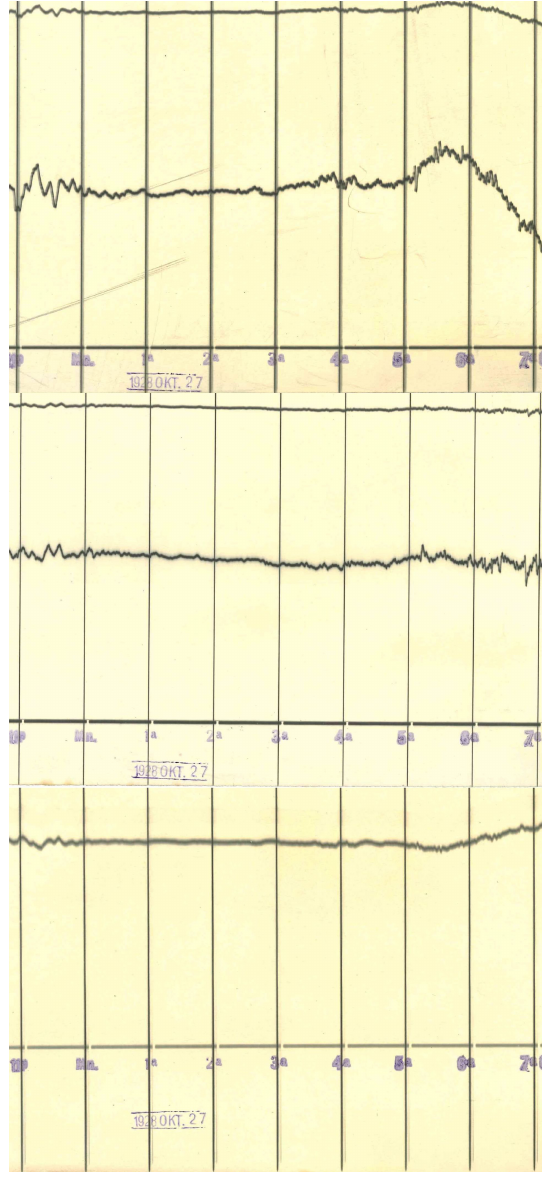
Figure 11. Seddin Observatory photographic recordings of the north (top), east (middle) and vertical component (bottom) of the time interval of 26 October 1928 at 23:00 till 27 October 1928 at 07:00 (Greenwich civil mean time) showing the disturbing effect of the Berlin suburban railway service. Source: Helmholtz Centre Potsdam –